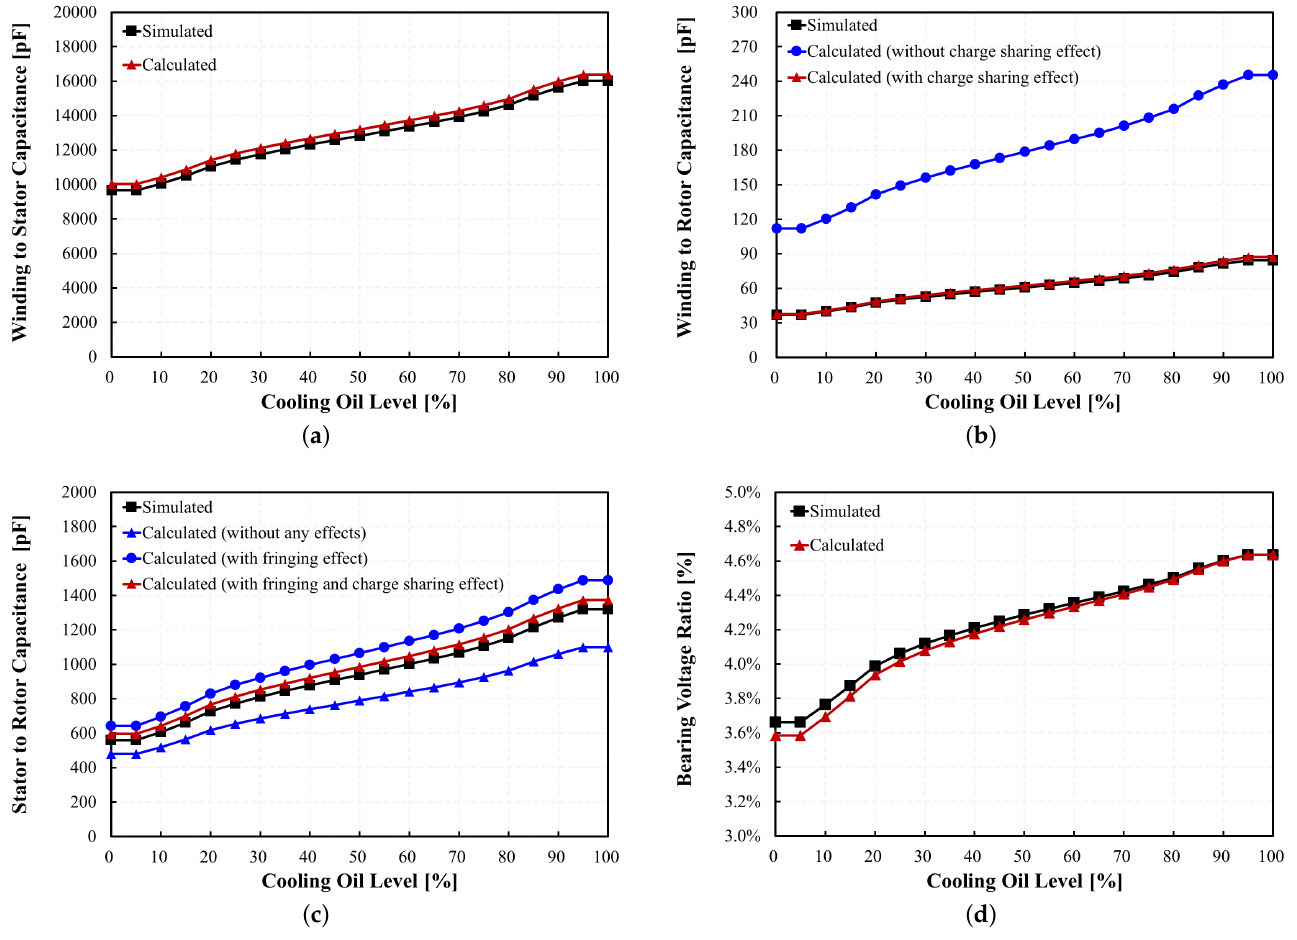
Figure 12. Results of calculation and simulation for parasitic capacitance and bearing voltage ratio. ( a ) Winding-to-stator capacitance; ( b ) winding-to-rotor capacitance; ( c ) stator-to-rotor capacitance; and ( d ) bearing voltage